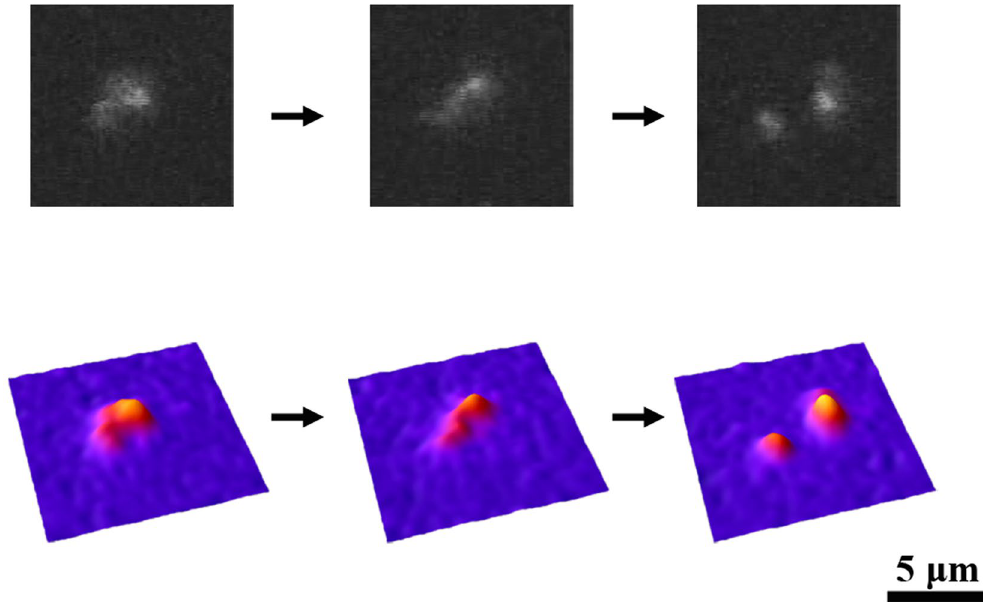
Figure 1. Example of the real-time observation of DSB caused by photo-irradiation-induced ROS. Fluorescence microscopic images of a single T4 DNA molecule under photo-irradiation (upper), and the corresponding quasi-three-dimensional profiles of the fluorescence intensity distribution (bottom). (Fluorescence dye: 0.05 μ M